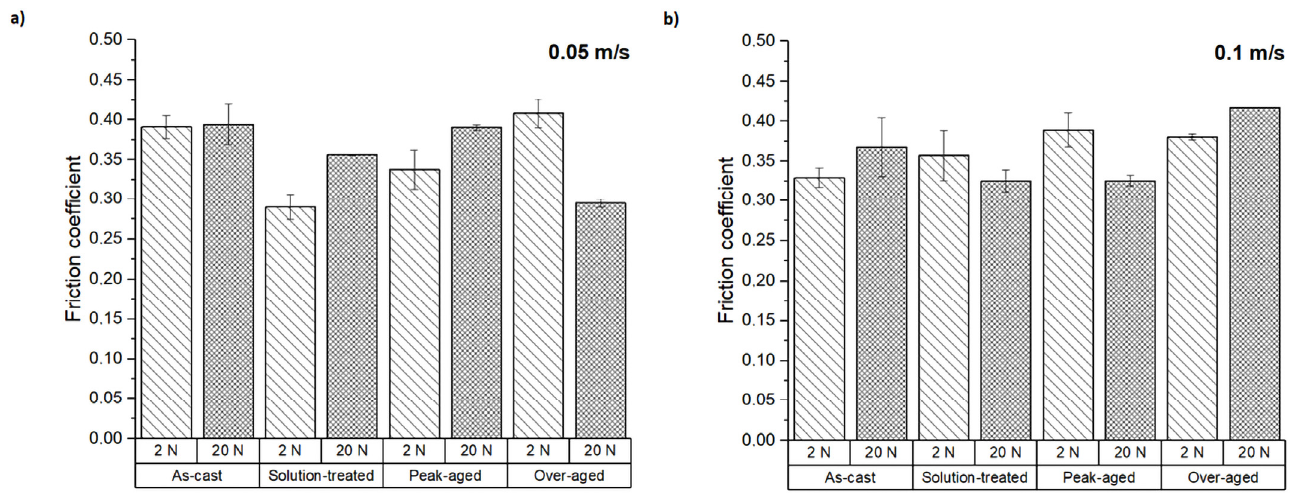
Figure 5. Friction coefficients at sliding speeds of ( a ) 0.05 m s − 1 and ( b ) 0.1 m s − 1 .